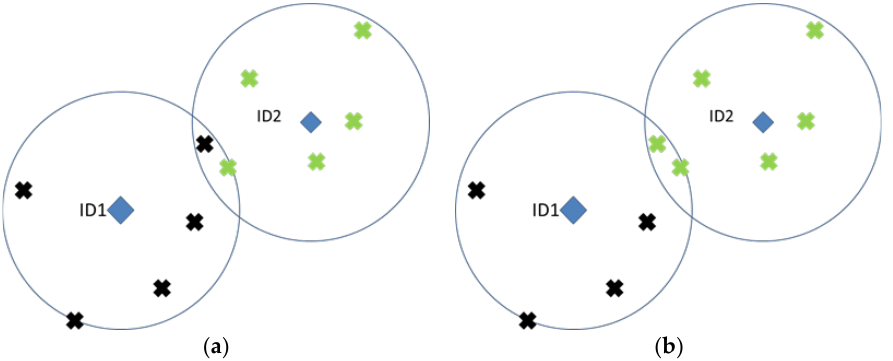
Figure 2. ( a ) Initial clustering. ( b ) A customer’s color changes from black to green after applying Algorithm 1.